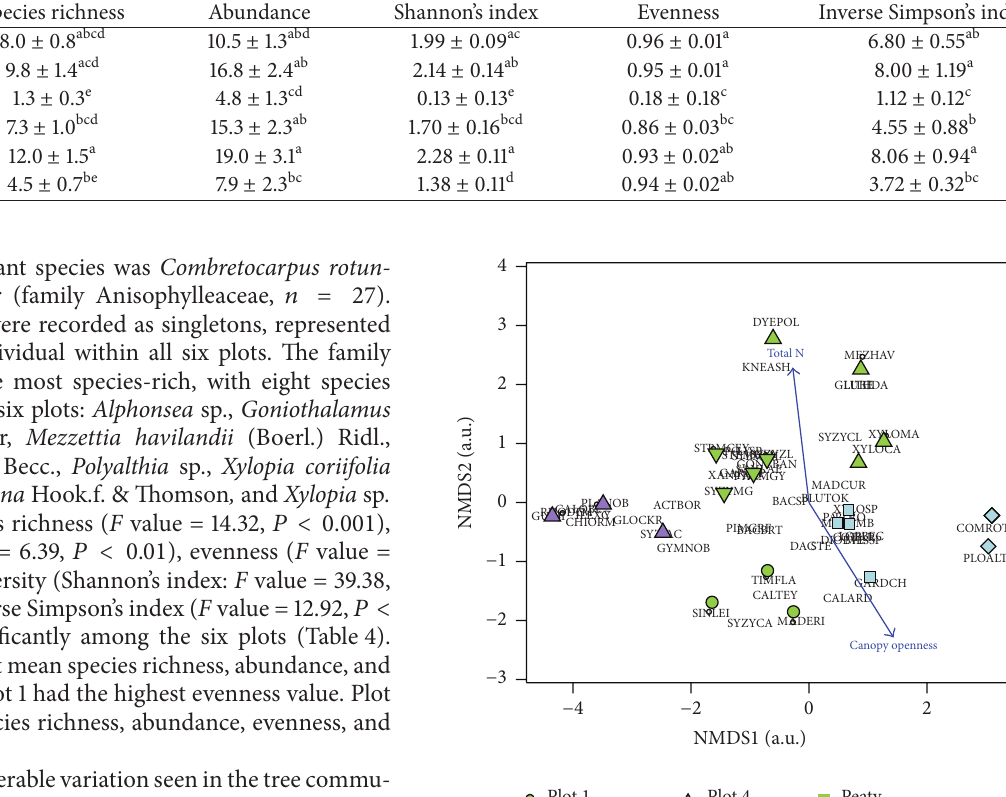
Table 4: Species richness, abundance, Shannon’s index, evenness, and inverse Simpson’s index of trees in six plots in the Tutong White Sands. Values are mean ± SE. Within each column, values followed by different letters are significantly different at 𝛼 = 0.05. Plot number